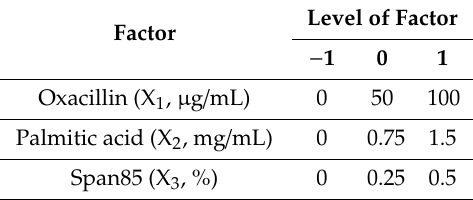
Table 1. Coded and real values of factors in the Box–Behnken experimental design.